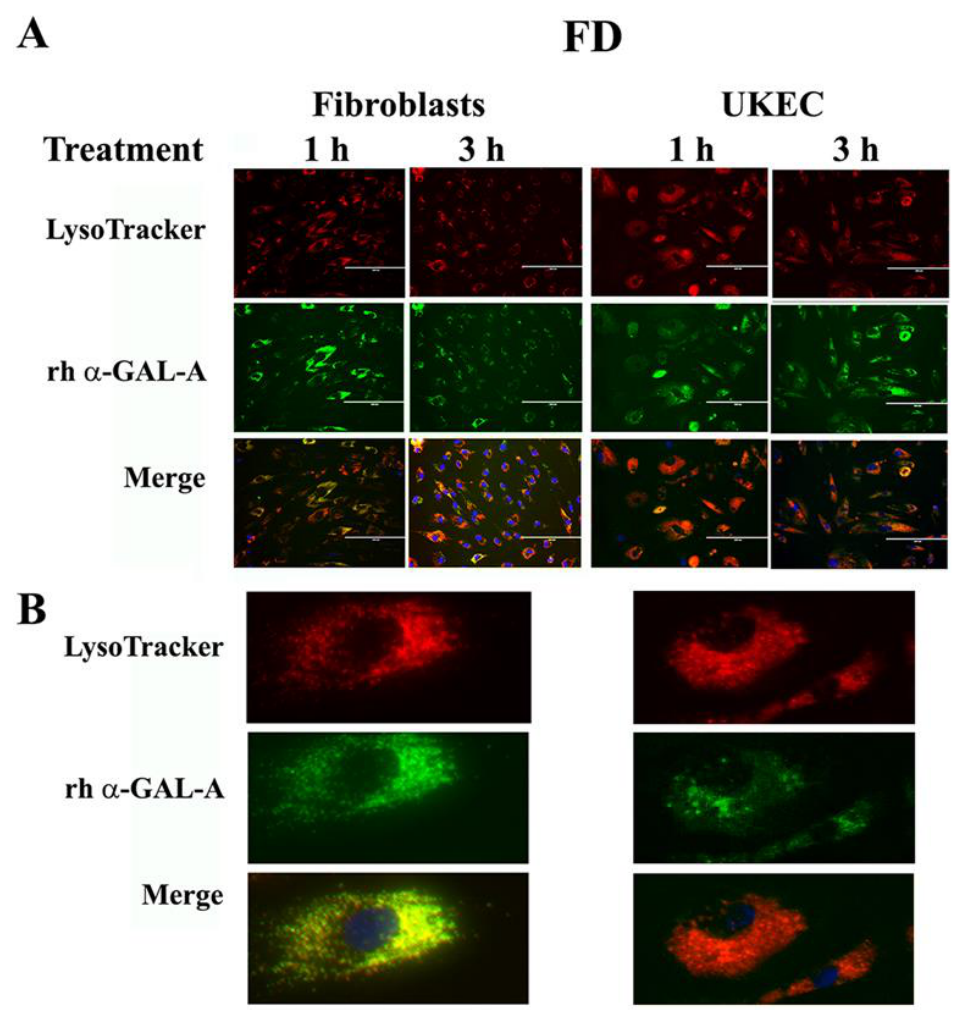
Figure 6. Immediate transport of rh-α-Gal-A to the lysosome. ( A ) Immunofluorescence images of FD fibroblasts and UKEC cells treated with fluorescence-labeled rh-α-Gal-A (green) and stained with LysoTracker (red). Bars: 200 μm. ( B ) Magnified image of cells with 1 h Alexa-Fluor-α-Gal-A conjugate treatment.